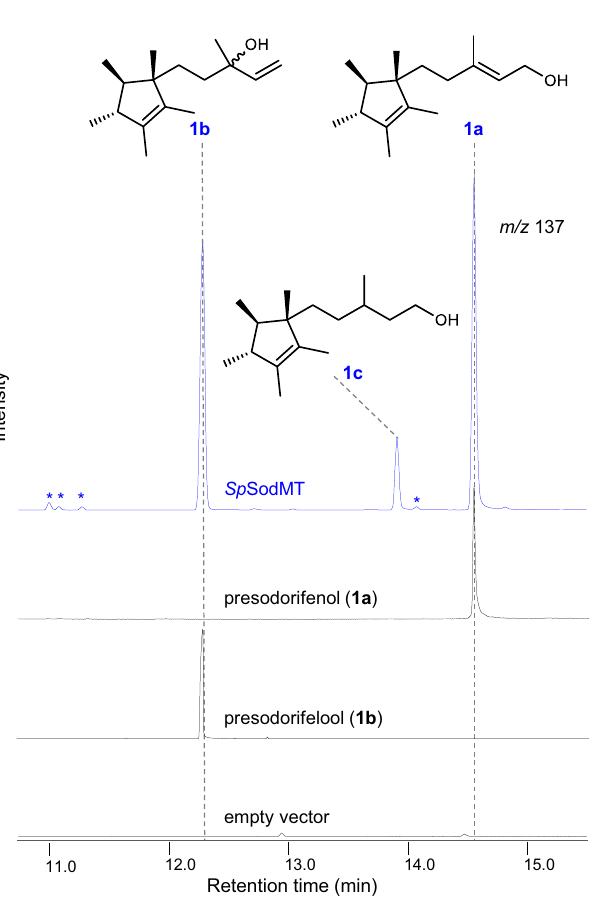
Fig. 1 | Expanding the terpenoid chemical space with C 16 terpenes. Canonical terpene biosynthesis is shown at the top (gray circles). IPP and DMAPP are con- densed by prenyltransferases (geranyl diphosphate synthase (GPPS), farnesyl diphosphate synthase (FPPS), geranylgeranyl diphosphate synthase (GGPPS)) to form building blocks of 10 (GPP), 15 (FPP), or 20 (GGPP) carbon atoms. Subse- quently,thesecanonicalbuildingblocksarecyclizedbyterpenesynthases(TPSs)to form hydrocarbons with the corresponding number of carbon atoms. Previously, weexpandedthechemicaldiversityofterpenoidsbysynthesizingC